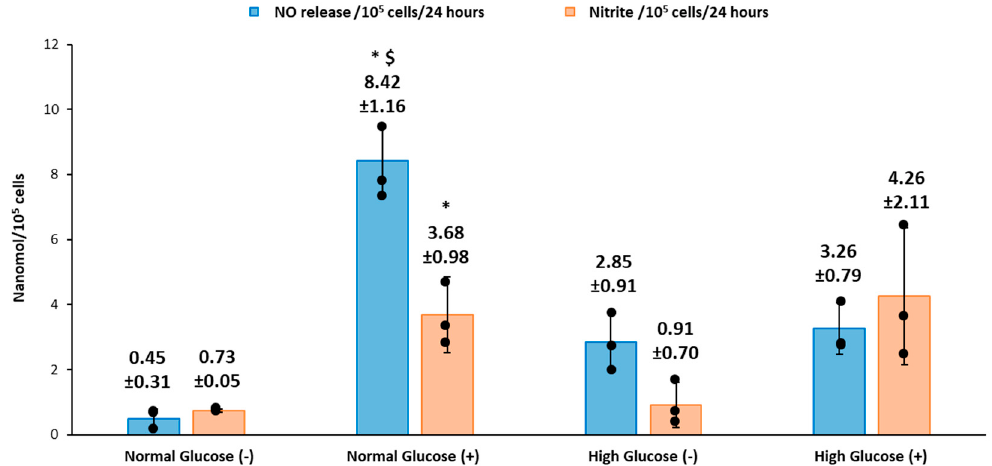
Figure 3. Total NO compared to nitrite accumulation determined for HDFa with and without stimulation under normal and high glucose conditions. (For n = 3, there is statistically significant difference at p < 0.05: * Normal glucose (LPS/IFN) vs. Normal glucose (without stimulation); $ Normal glucose (LPS/IFN) versus High glucose (LPS/IFN), dots on each average bar indicate individual data points.